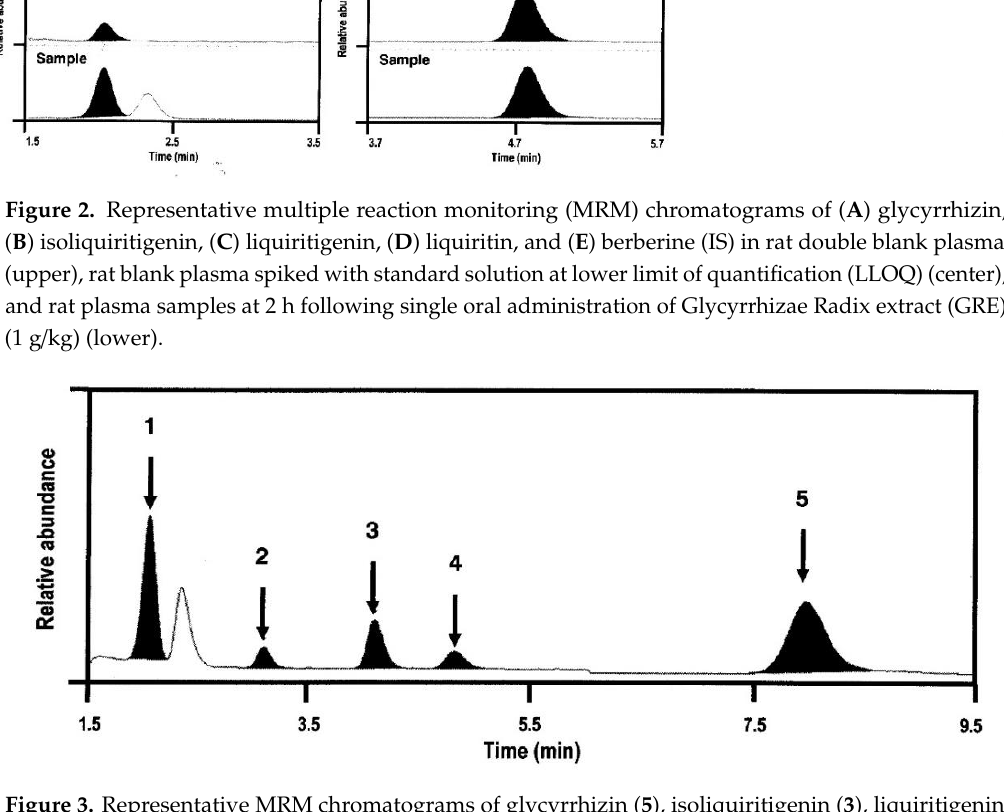
Figure 3. Representative MRM chromatograms of glycyrrhizin ( 5 ), isoliquiritigenin ( 3 ), liquiritigenin ( 2 ), liquiritin ( 1 ), and berberine ( 4 ) in rat plasma samples at 2 h following single oral administration of GRE (1 g/kg).